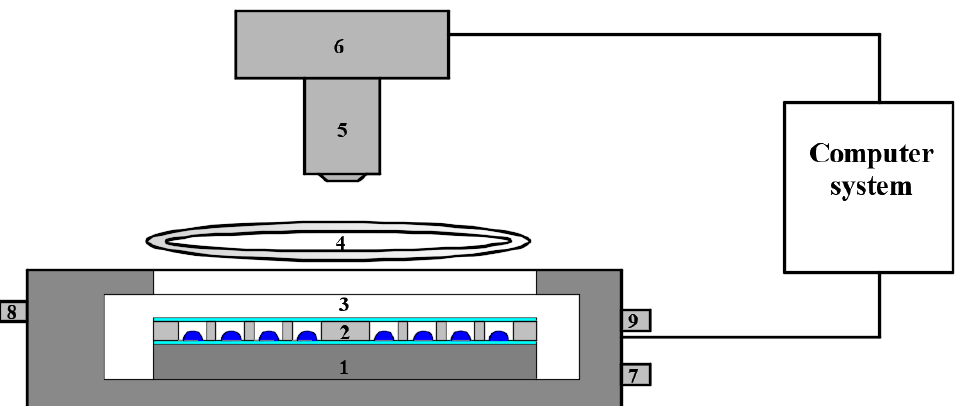
Figure 1. Schematic diagram of the PeKing University Ice Nucleation Array (PKU-INA). (1) cold-stage; (2) spacer; (3) glass slides; (4) ring light emitting diode (LED) light; (5) lens; (6) charge-coupled (CCD) camera; (7) circulating cooling water; (8) inlet for the high-purity nitrogen flow; (9) outlet for the high-purity nitrogen flow.